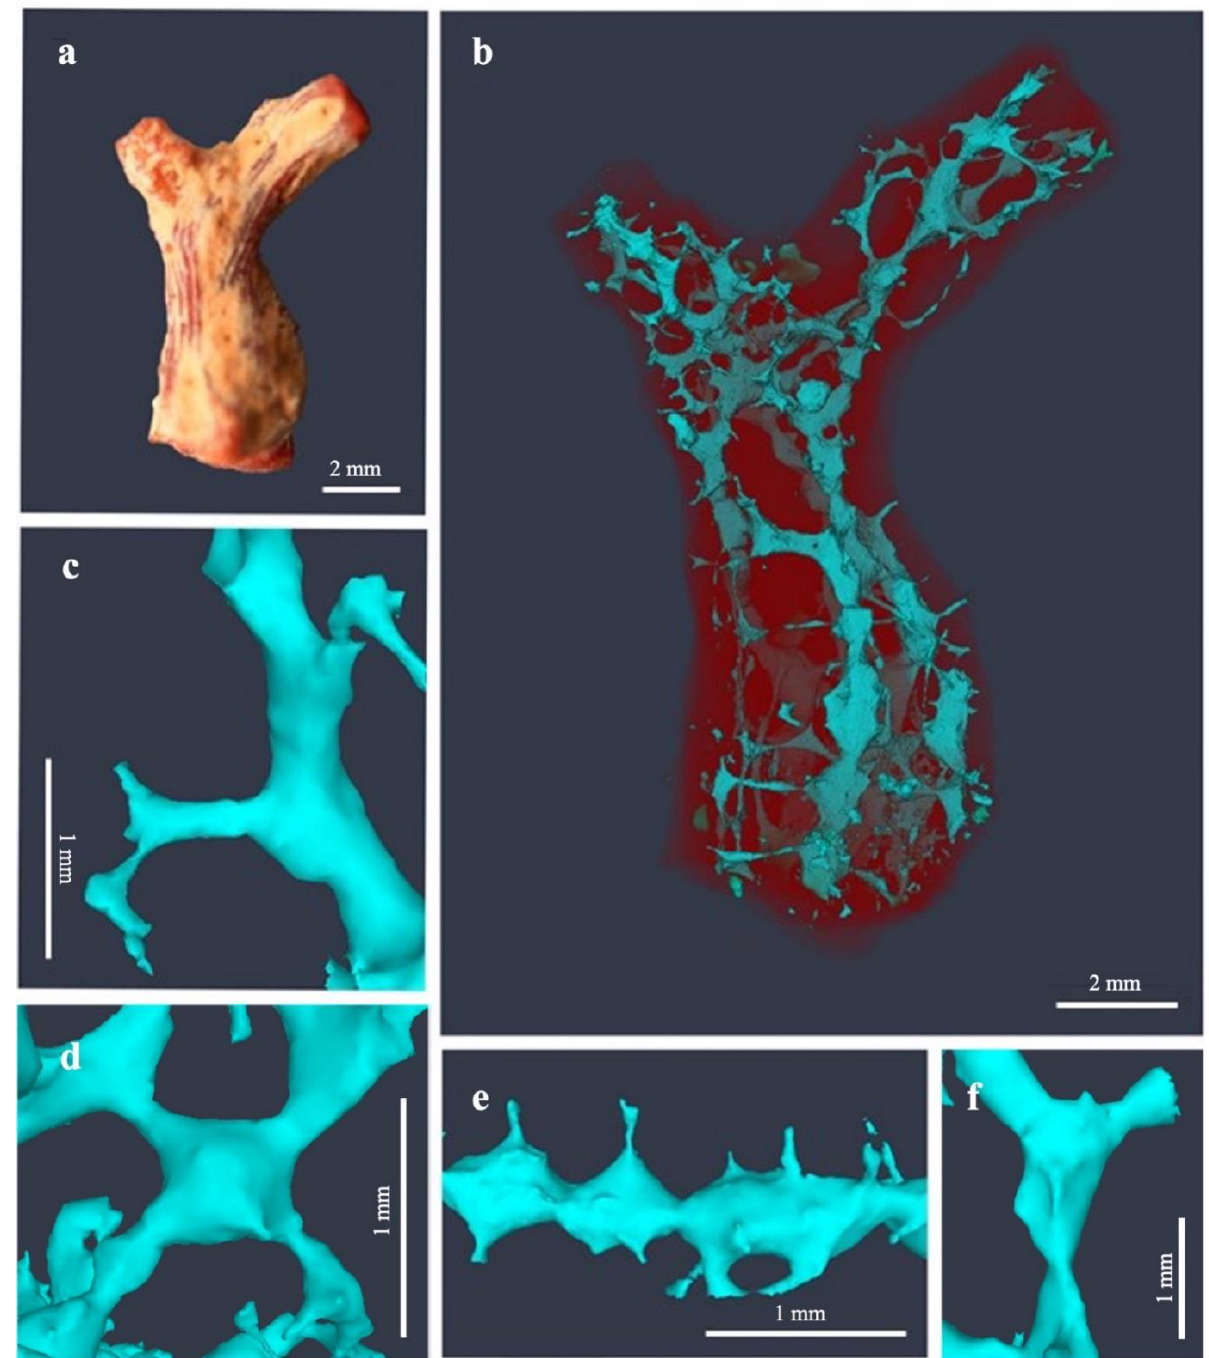
Figure 8. Three-dimensional visualisation of the red coral sample excavated by Dotona pulchella mediterranea , from micro-CT reconstructions: ( a ) red coral sample CT2; ( b ) D. pulchella mediterranea cavities represented in blue and coral in transparent red; ( c – e ) different shape of chamber intersections: L, X, and T-shaped, respectively; ( f ) moniliform perforation pattern produced by D. pulchella mediterranea .